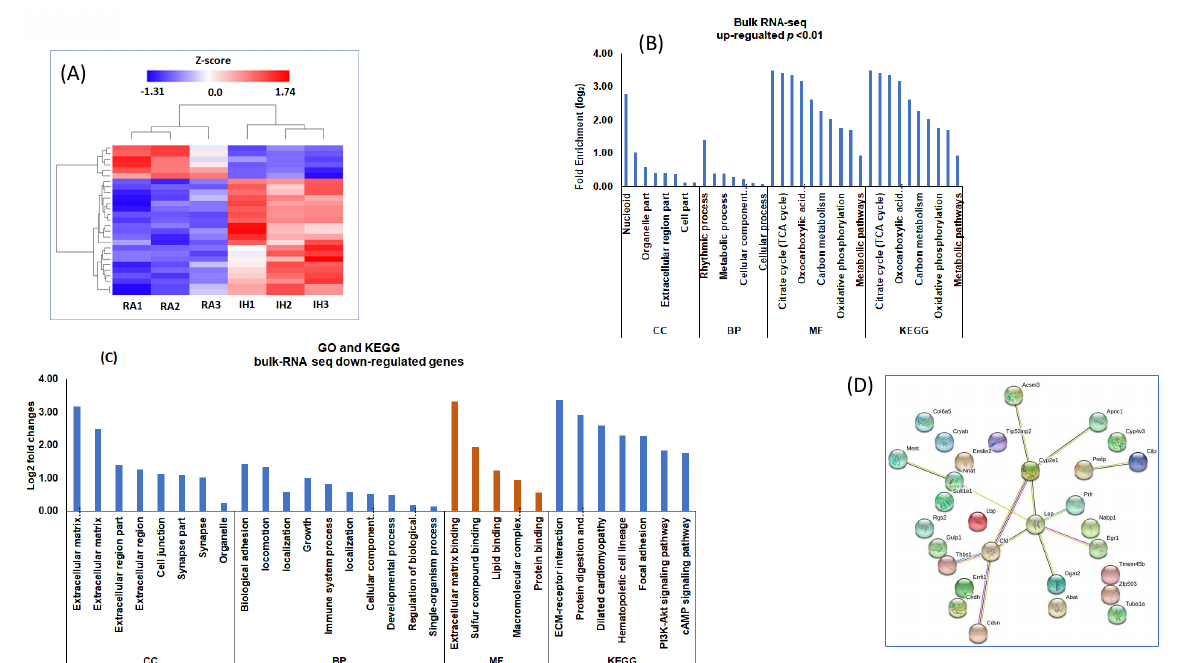
Figure 5. Bulk RNA-seq in vWAT of mice exposed to IH and RA for 6 weeks. The differentially expressed genes were used for gene ontology (GO), Kyoto Encyclopedia of Genes and Genomes (KEGG) pathways, and gene network interactions. ( A ) Hierarchical clustering analysis of gene expression profiles. Each column indicates a sample, whereas each row indicates a gene. Red color indicates upregulation and blue color downregulated genes. ( B ) Gene Ontology (GO) and KEGG for the upregulated differentially expressed bulk RNA-seq in vWAT from mice exposed to RA or IH for 6 weeks. ( C ) GO and KEGG for the downregulated differentially expressed genes. GO analysis was used to assess cellular components (CC), biological processes (BP), and molecular functions (MF). ( D ) Gene networks of the top 30 DEGs (15 upregulated and 15 downregulated) to construct gene-gene interactions using the STRING software. n =